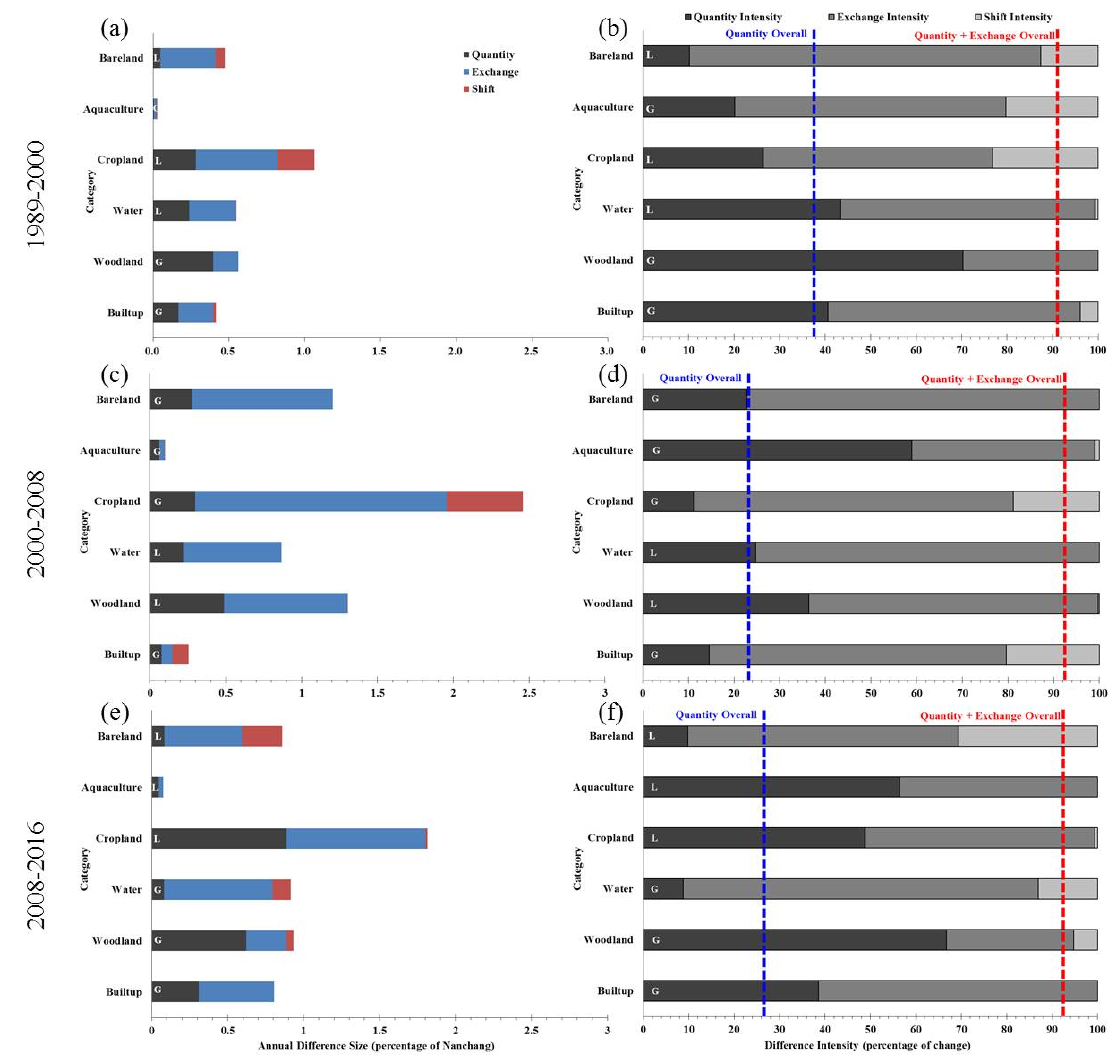
Figure 8. ( a ), ( c ), ( e ) Size and ( b ), ( d ), ( f ) Intensity of differences during three time intervals in Nanchang. L denotes net loss and G denotes net